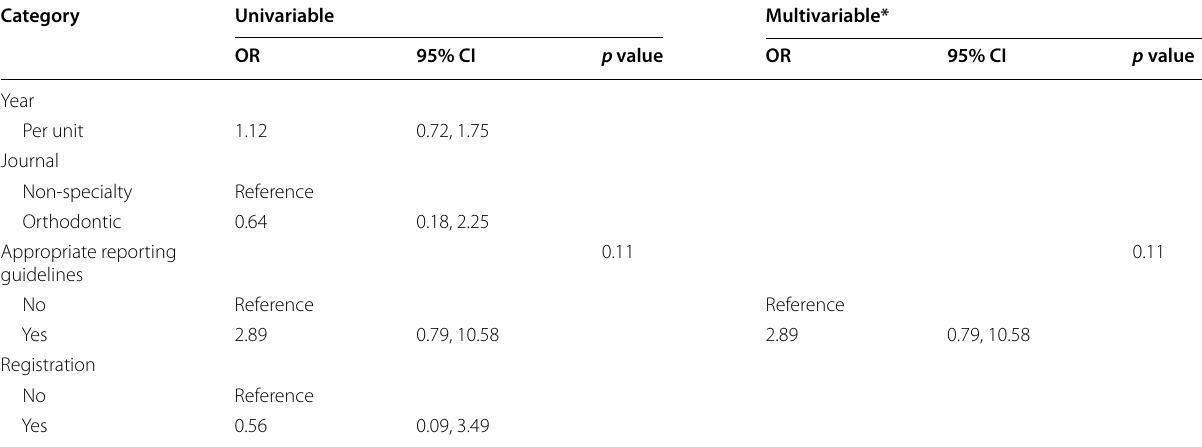
Table 3 Univariable and multivariable logistic regression with odds ratios (ORs) and respective confidence intervals (CIs) for the effect of year, journal, appropriateness of reporting guidelines used and registration, on adequate justification for the conduct of a